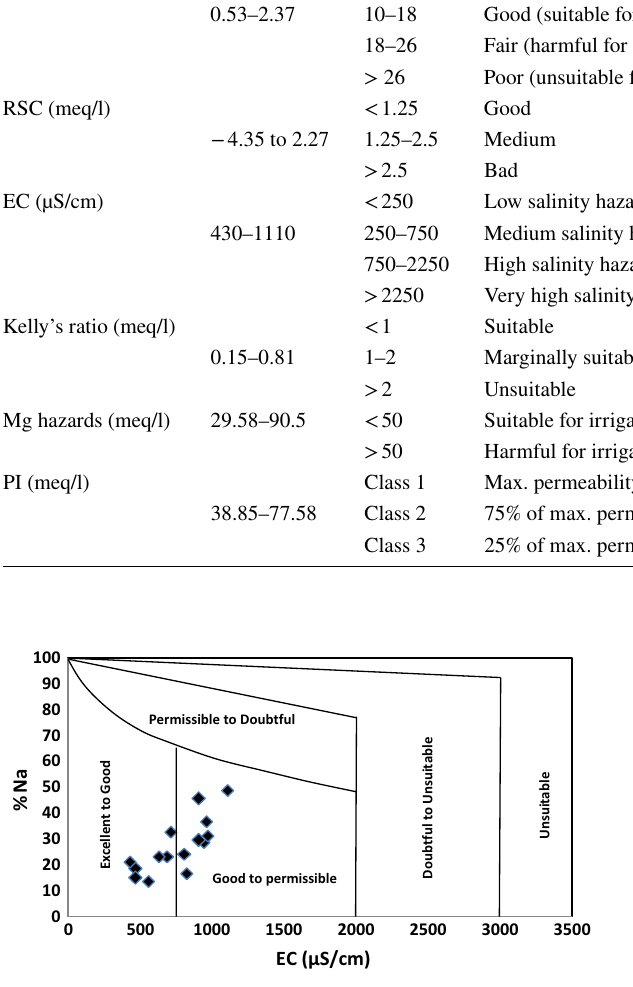
Fig. 6 Rating of groundwater samples based on electrical conductiv- ity and percent sodium (Wilcox 1948)